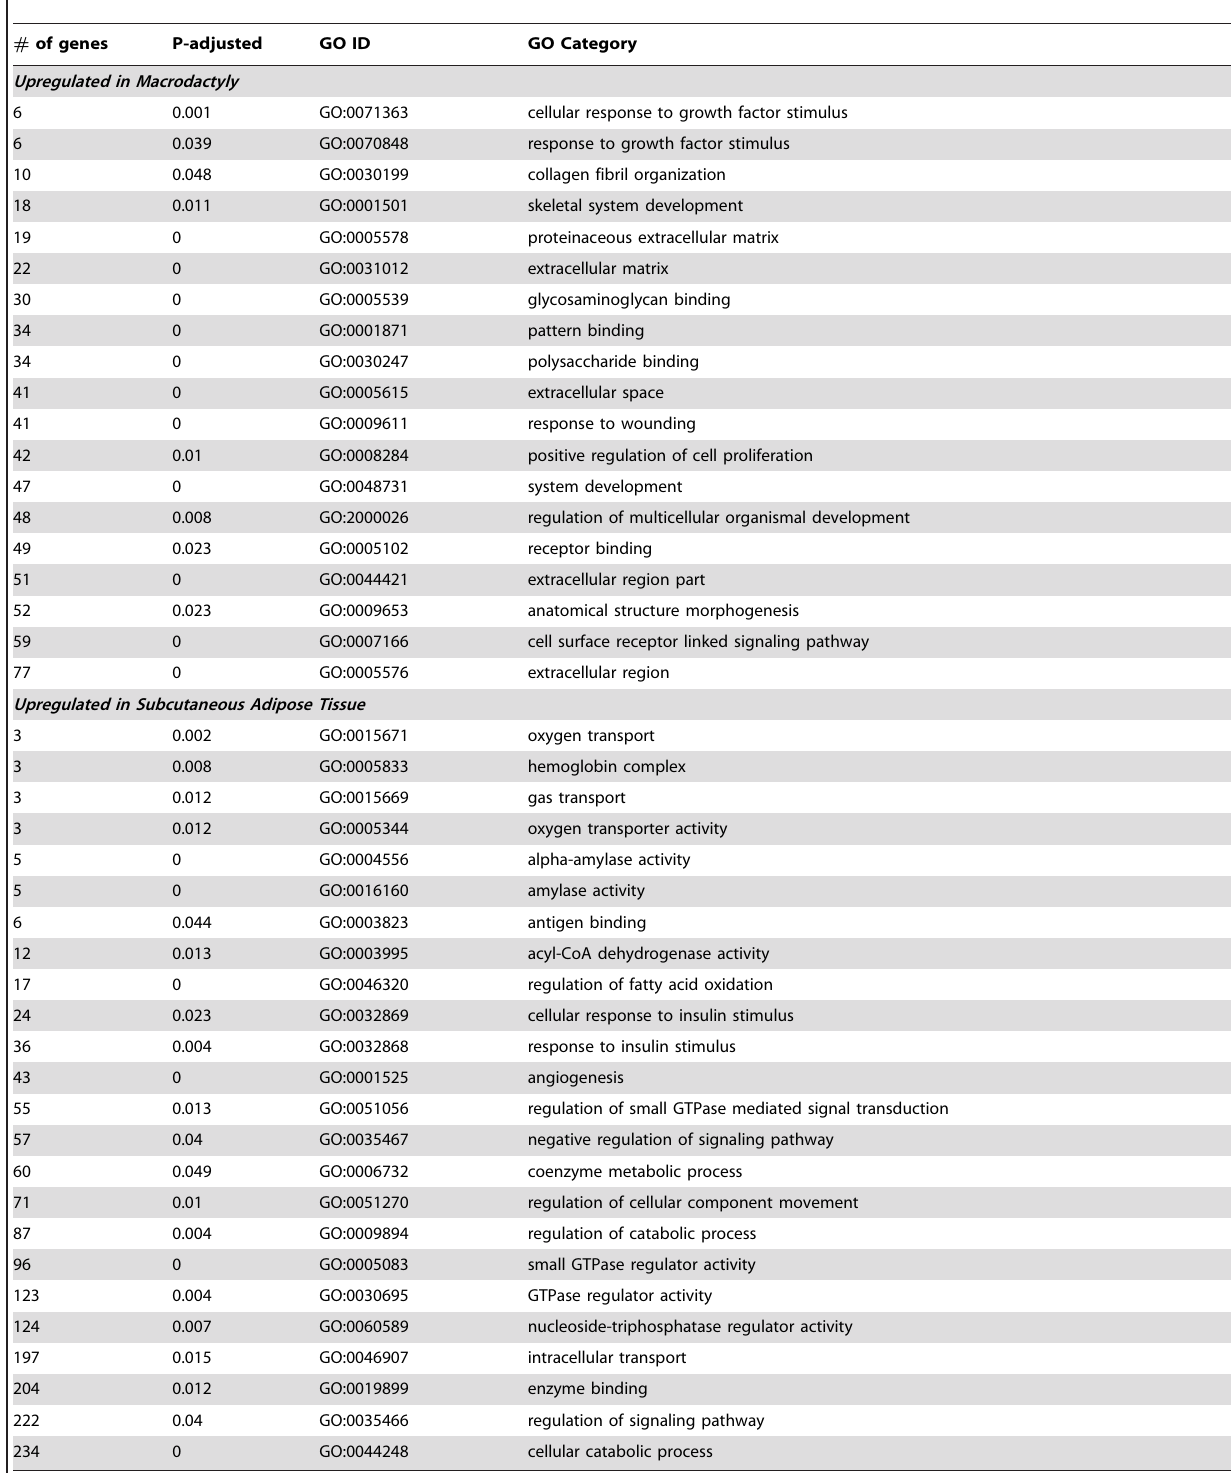
Table 2. Enriched gene ontology categories in macrodactyly and subcutaneous adipose